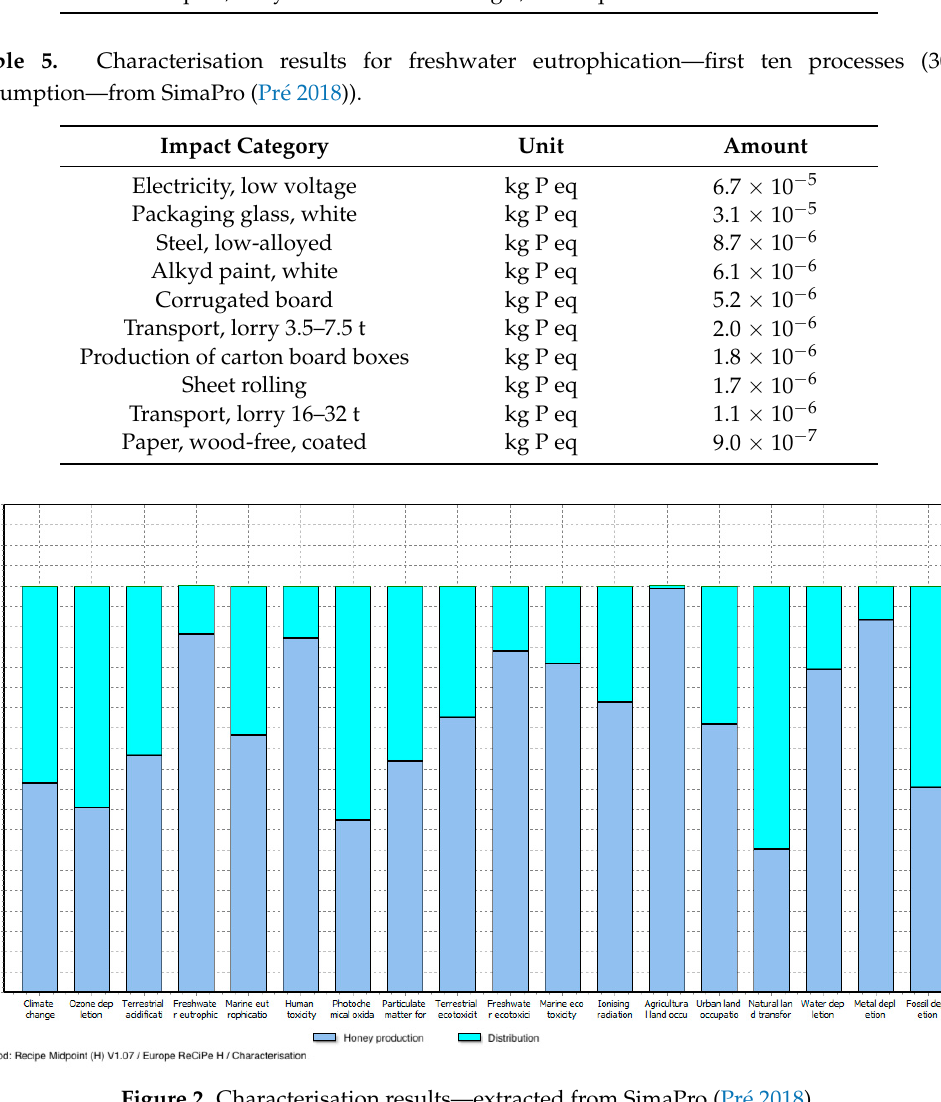
Figure 2. Characterisation results—extracted from SimaPro (Pré 2018).